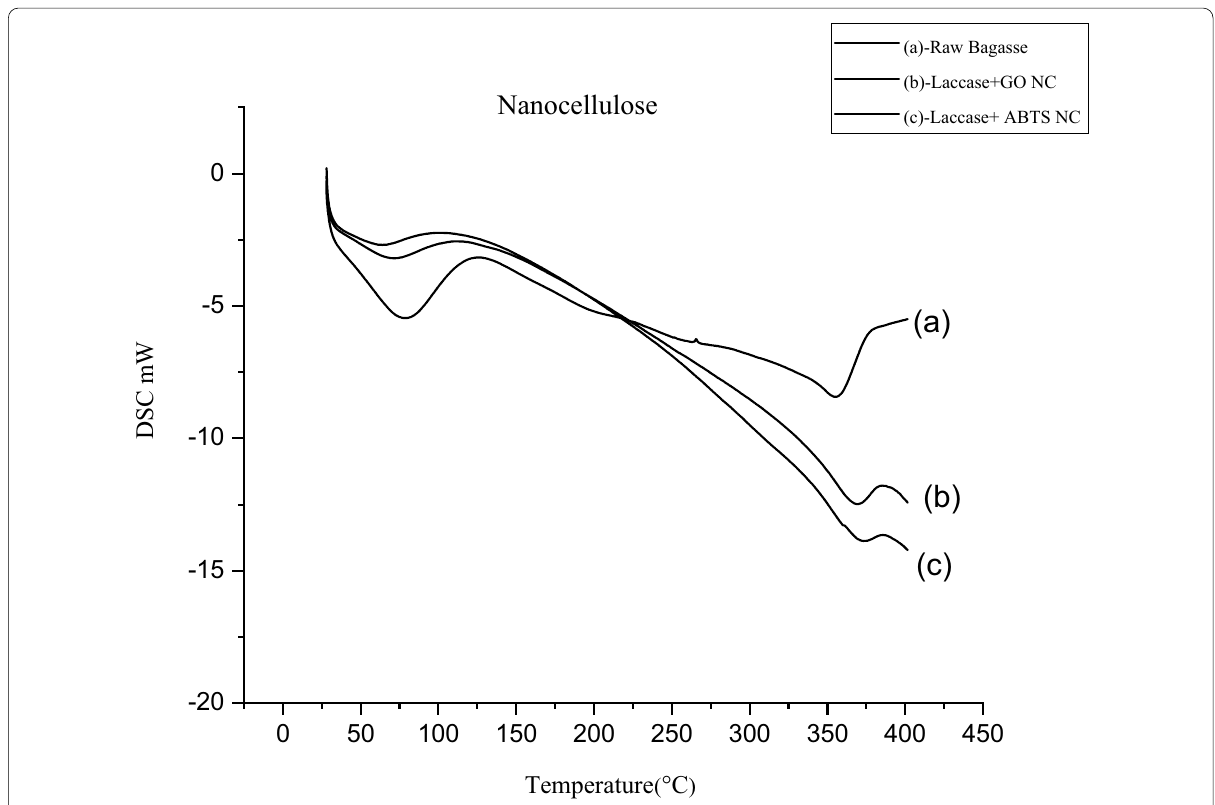
Fig. 10 DSC thermograms for ( a ) raw bagasse, ( b ) laccase